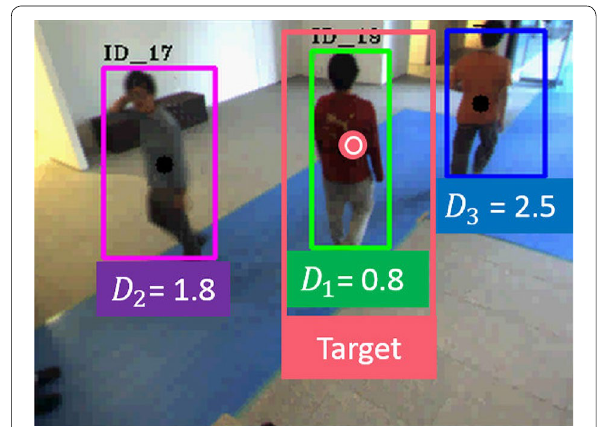
Fig. 10 Evaluation value for data association. The evaluation value, D , is shown below the detection window. The tracker is associated with the middle person in this